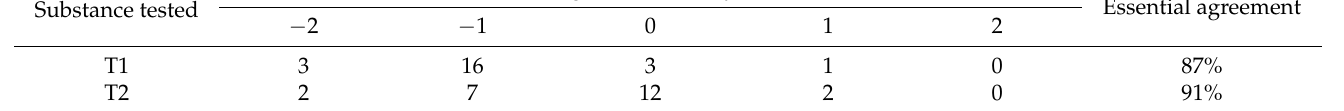
Table 4. Summary of changes in inhibition diameter zones depending on the source of the